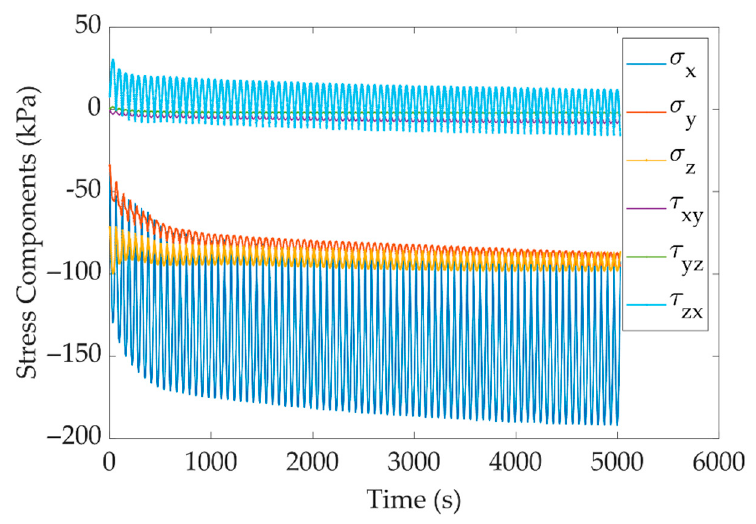
Figure 3. Variation of stress components during applied cyclic loading for element E1.